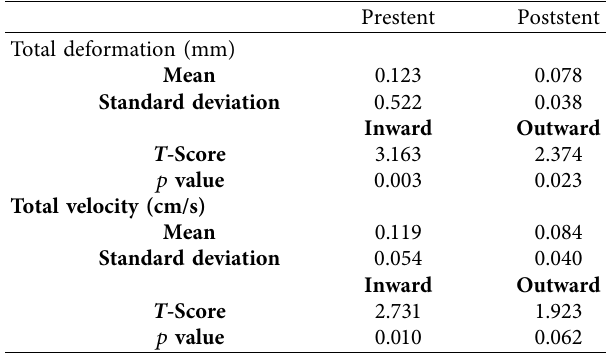
Table 1: Coronary artery wall radial deformation (mm) and ve- locity